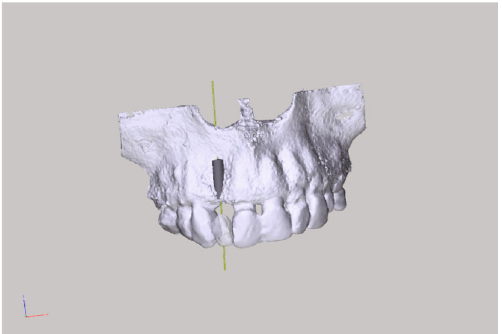
Figure 4: Rendered 3D planning model (STL fi le) showing a virtual implant in position